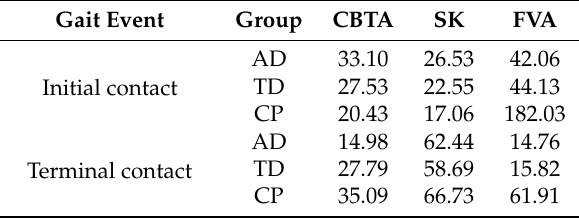
Table 3. Percent gait detection reliability (GDR) of gait event detection methods (GEDM).